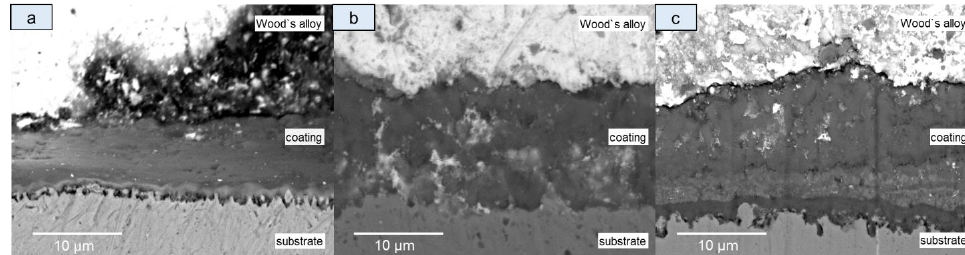
Figure 5. SEM images of coatings (δCo/δMn = 1.5/0.5 μm) before the heat resistance tests ( a ), after 50 h ( b ), and after 100 h of testing ( c ).